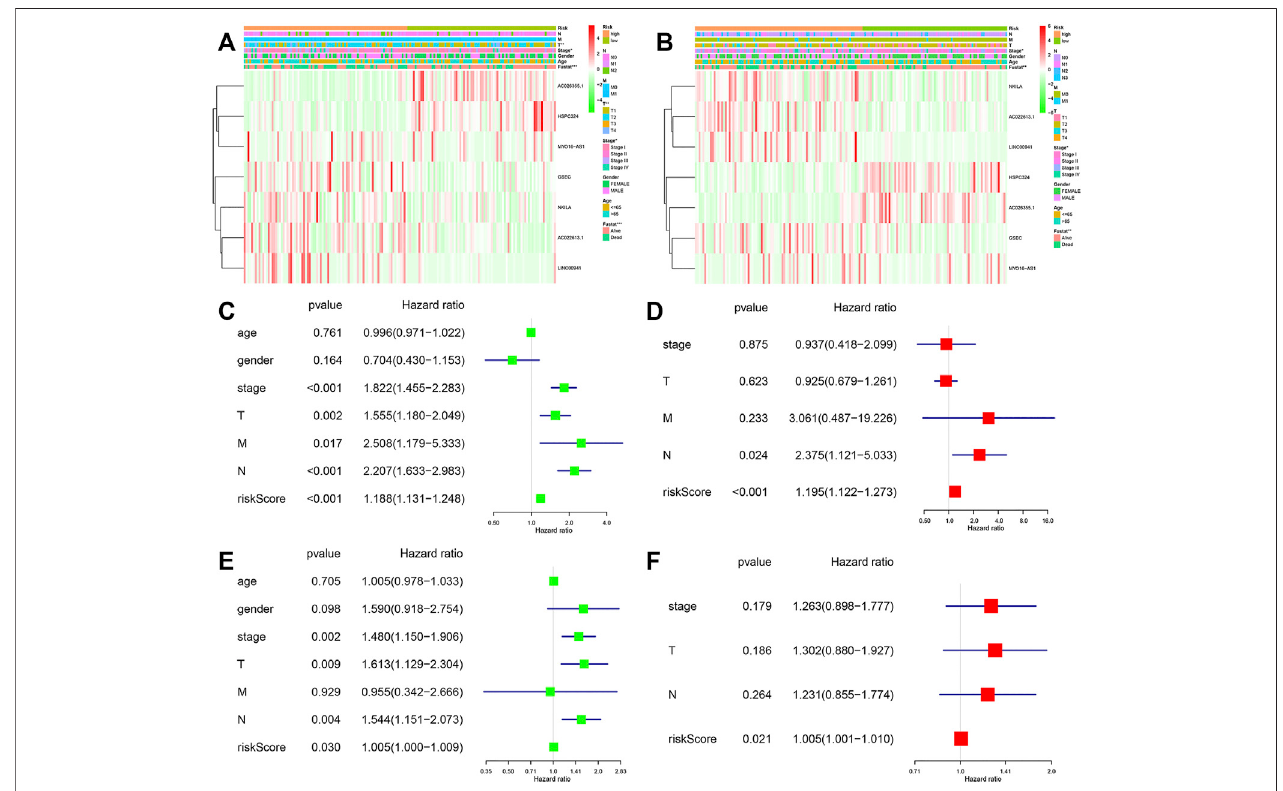
FIGURE 5 | Forest plots of the univariate and multivariate Cox analysis in LUAD patients. Heatmap and clinico-pathologic features of the seven hypoxia-related lncRNAs (A) in the training, and (B) validation cohorts. Univariate and multivariate analyses for OS (C,D) in the training and (E,F) validation